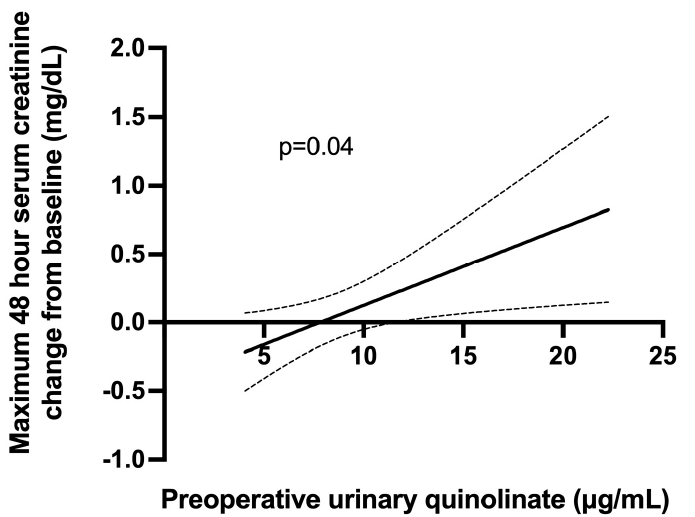
Figure 3. Preoperative urinary quinolinate concentrations and maximum change in serum creatinine from baseline 48 h postoperatively. Dotted lines denote the 95% confidence interval.